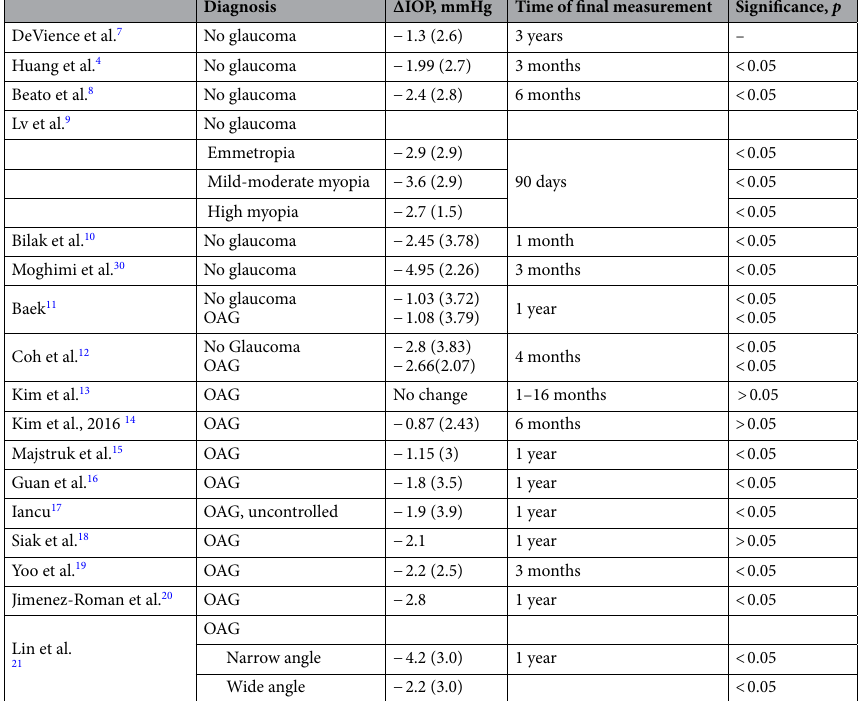
Table 5. Studies, evaluating ΔIOP in OAG and non-glaucomatous cataract patients, conducted in last 10 years, measured with Goldmann applanation tonometry.